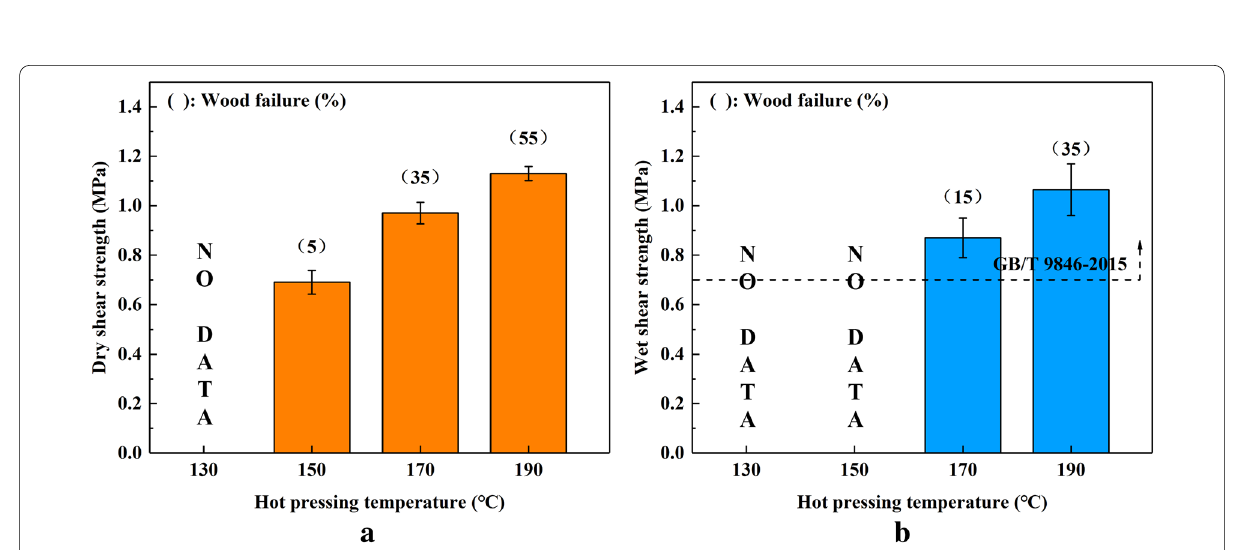
Fig. 3 Effects of the hot pressing temperature on the a dry and b wet shear strength of the plywood bonded by EHADP